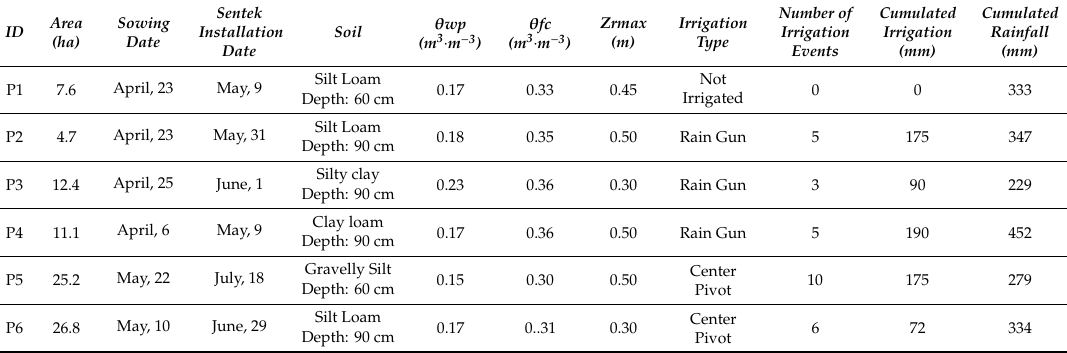
Figure 1. Location of the six experimental plots in South West France with their corresponding nearest Word Meteorological Organization (WMO) synop stations. Table 1. Description of the six experimental plots. Irrigation and precipitation depths are summed between sowing and harvesting.